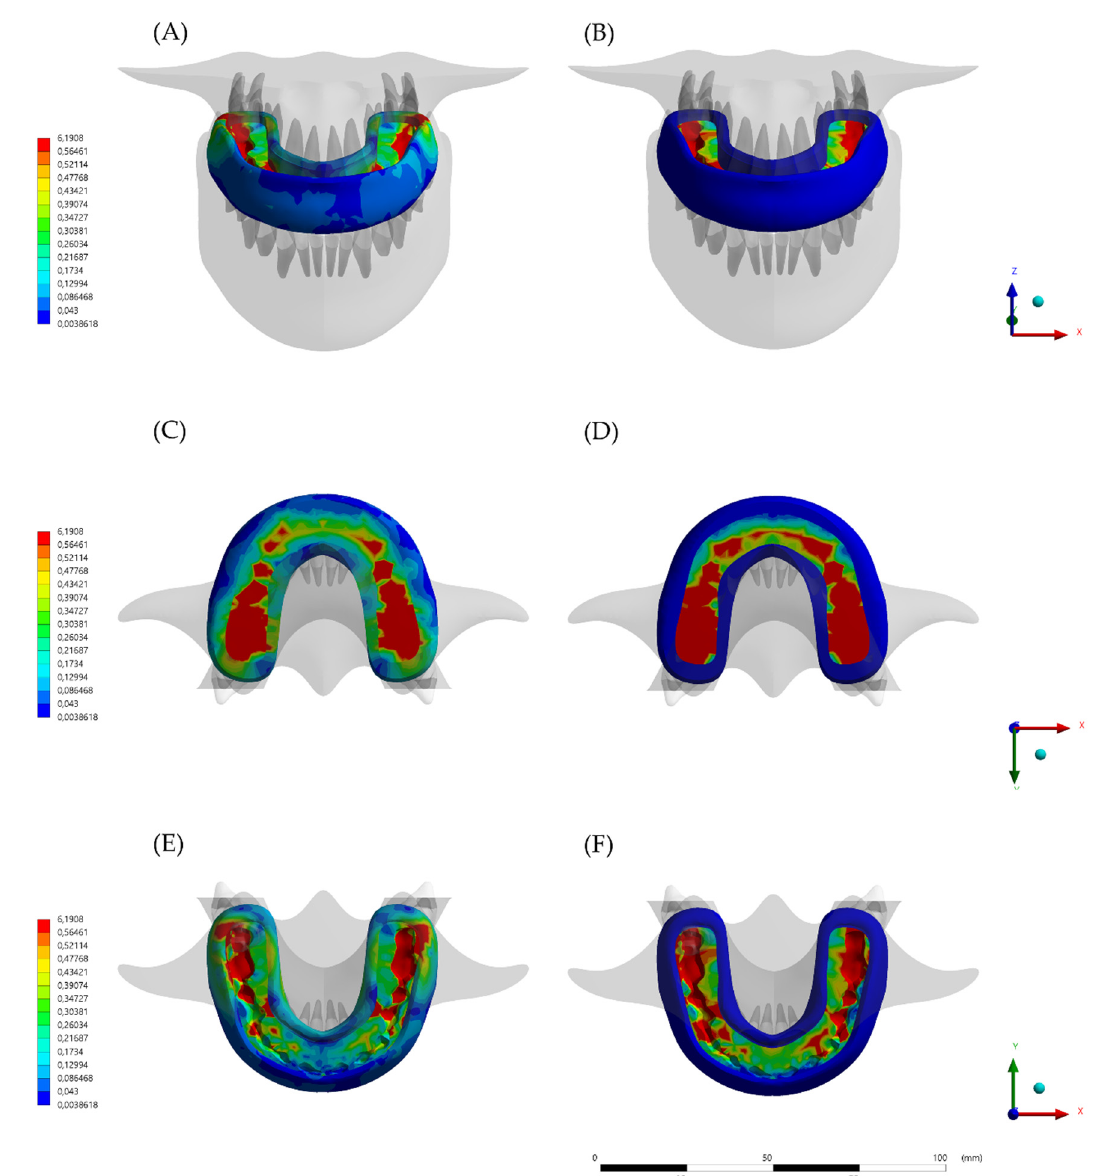
Figure 6. Stress maps in the devices after the loading according to the different designs and viewports. ( A ) Buccal view of the mouthguard device stress with the conventional (MG) design, ( B ) Buccal view of the mouthguard device stress with the hybrid (HMG) design, ( C ) Occlusal view of the mouthguard device stress with the conventional (MG) design, ( D ) Occlusal view of the mouthguard device stress with the hybrid (HMG) design, ( E ) Inside view of the mouthguard device stress with the conventional (MG) design, and ( F ) Inside view of the mouthguard device stress with the hybrid (HMG) design.